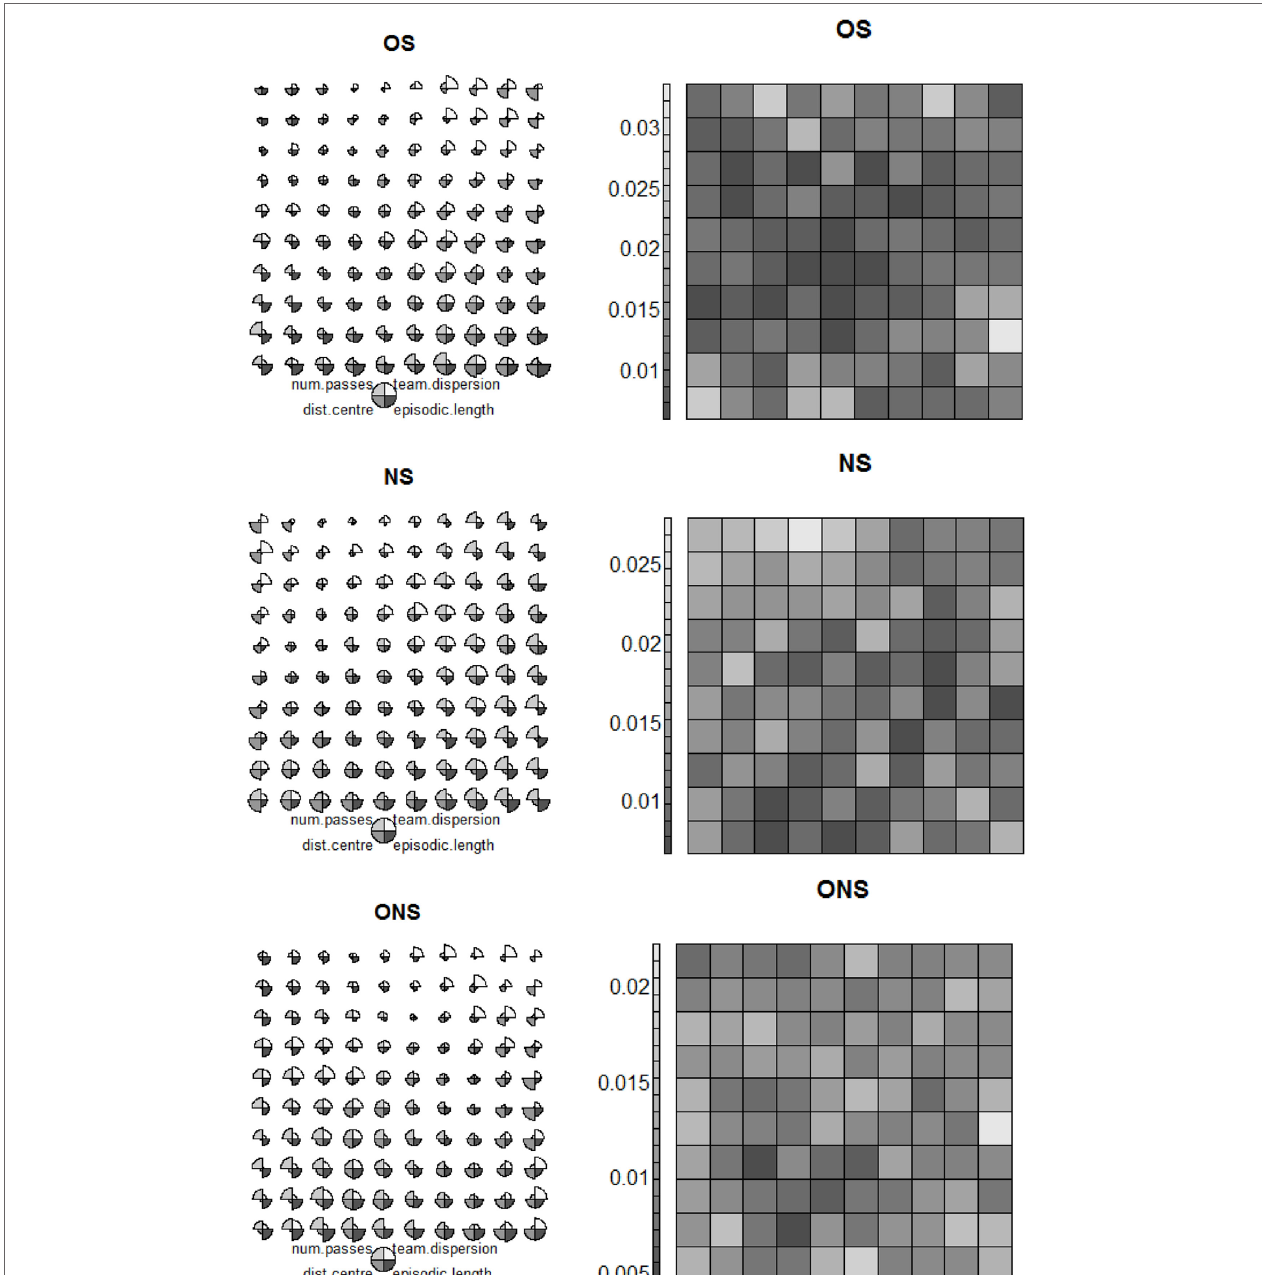
FigUre 4 | Left: Self-organizing map (SOM) visualizing behavior space exploration at the final generation of OS, NS, and ONS search variant in 6vs5 keep-away. Each circle represents a behavior type (four colored slices). Each slice represents one component of the behavior characterization vector (Section 3.4.1), where slice size equates to the given component’s value. Right: U-matrix visualizing the clustering of behavior types (nodes in the SOM, left) in the behavior space at the final generation of OS, NS, and ONS. The darker the color between two adjacent nodes the closer the distance between the two behavior types in the behavior space. Note the differing u-matrix Y-axis values indicating normalized behavioral